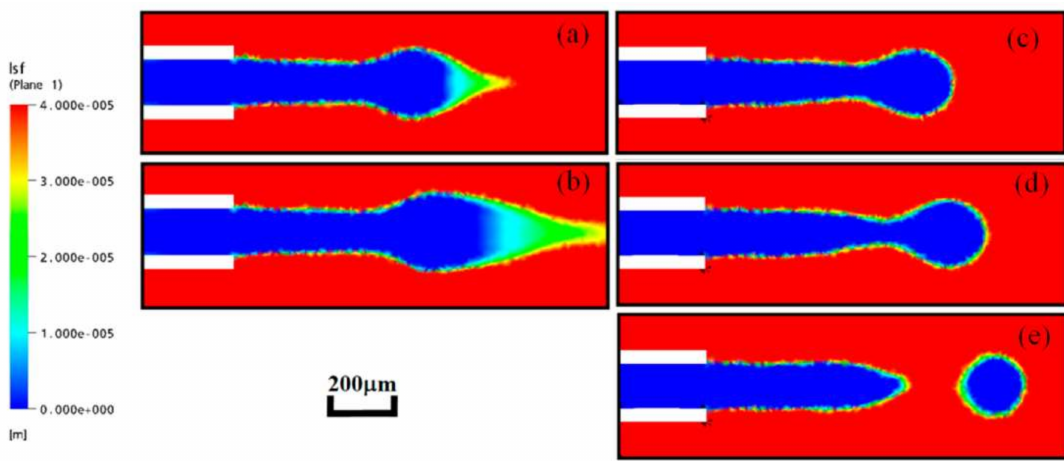
Figure 7. Simulation results comparison between the improved level set method and original level set method: ( a,b ), simulated by original level set method, ( c – e ), simulated by improved level set method. Reprinted with permission from [82].